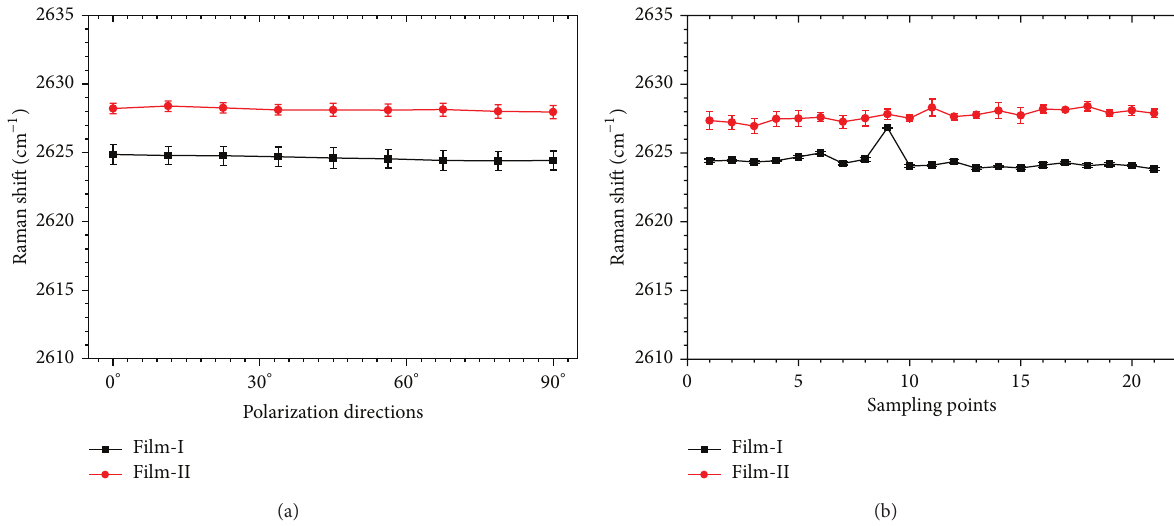
Figure 4: (a) Raman shifts (average of 21 points) at nine different polarization directions without loading. (b) Raman shifts (average of nine polarization directions) of 21 different points without